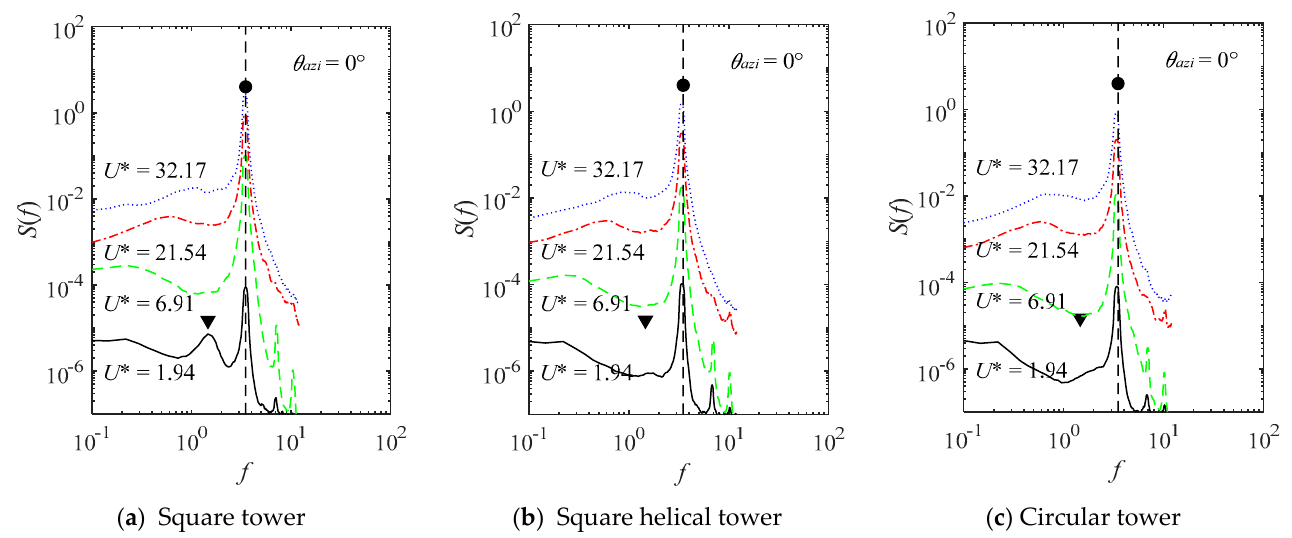
◦ and θ ◦ wd = 0 azi = 0